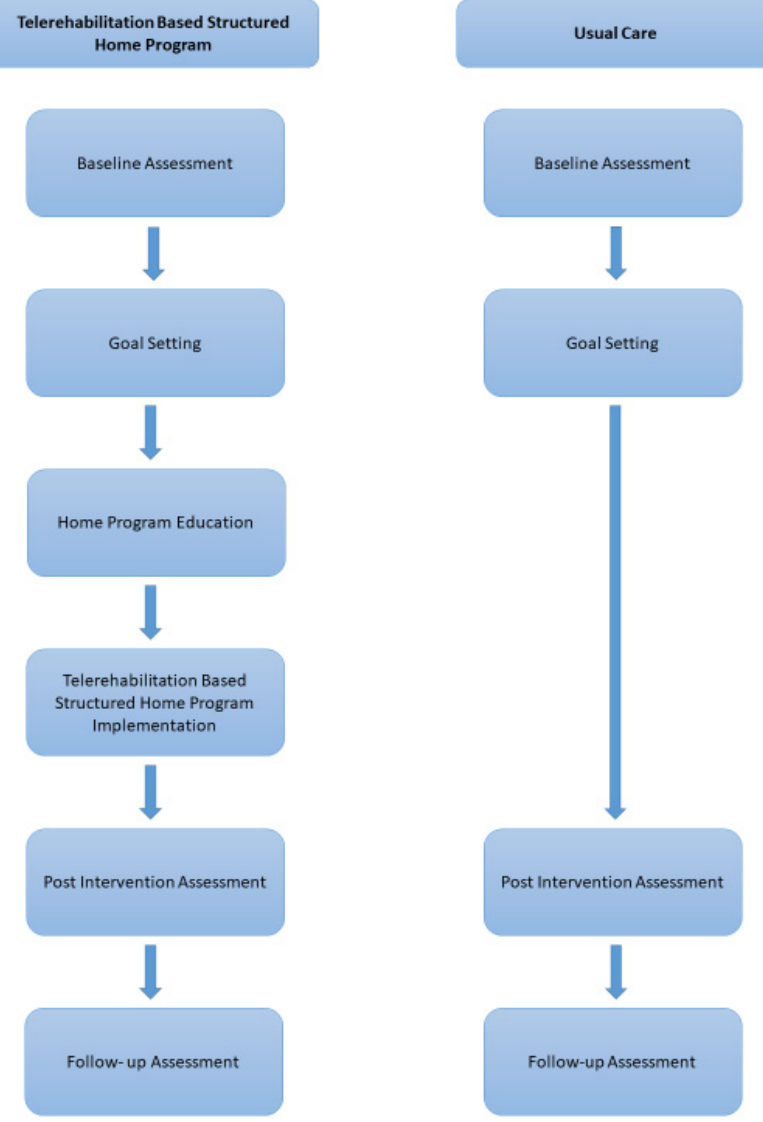
Figure 2. Telerehabilitation-Based Structured Home Program Approach diagram.